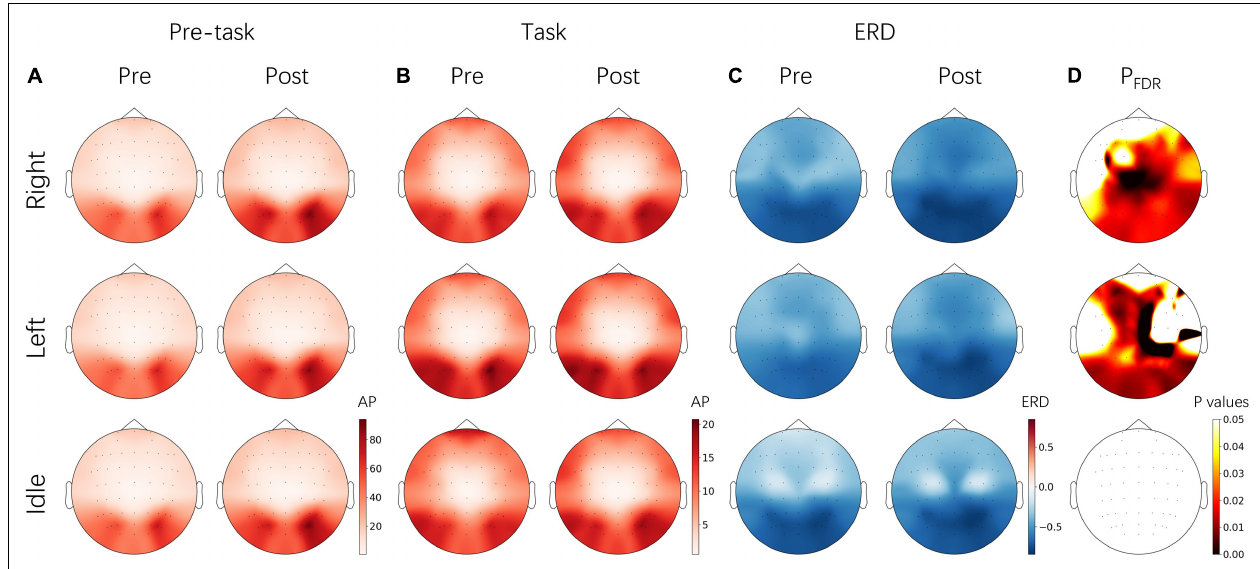
FIGURE 7 | Topographical images of alpha-band absolute power (AP) and ERD from pre-NFT (Pre) and post-NFT (Post) MI session and three tasks, respectively. (A) The AP from the pre-task stage (–3 – 0 s). (B) The AP from the task stage (0 – 4 s) (C) The ERD. (D) The significant difference of ERD from the paired t -test – the p values of electrodes were corrected by FDR. The images of each panel share the same color bars on the bottom right, respectively. right, right-hand MI; left, left-hand MI; idle, idle task.